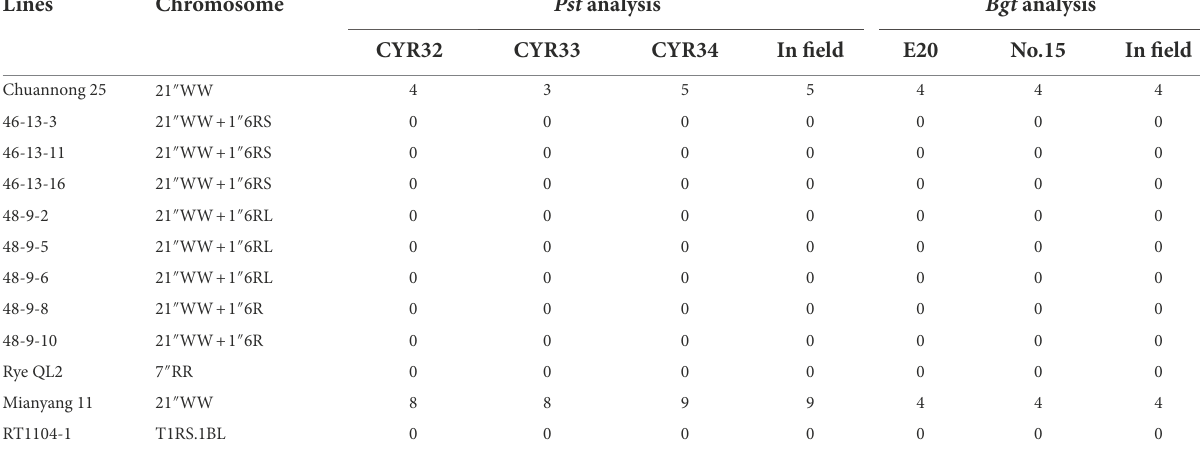
TABLE 3 Analysis of resistance to stripe rust and powdery mildew when inoculated with prevalent races/isolates of stripe rust and powdery mildew. Lines